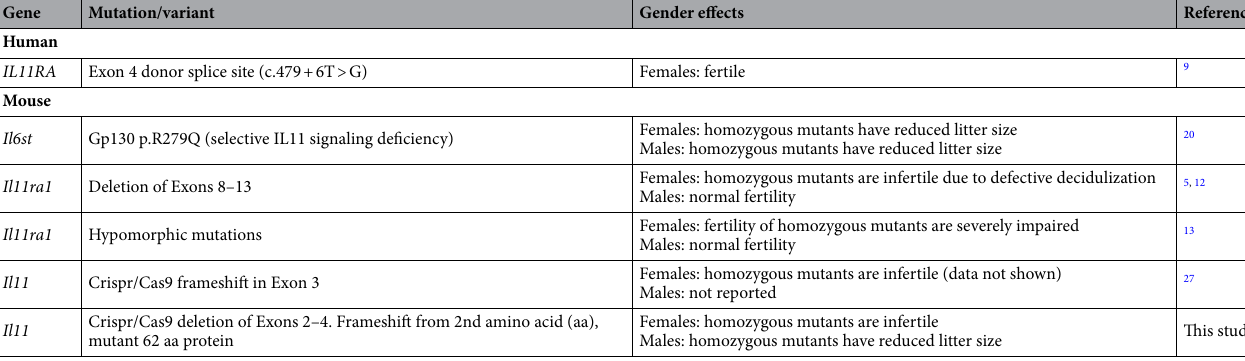
Table 2. Fertility reported with genetic loss-of-function in IL11 signaling in mice and